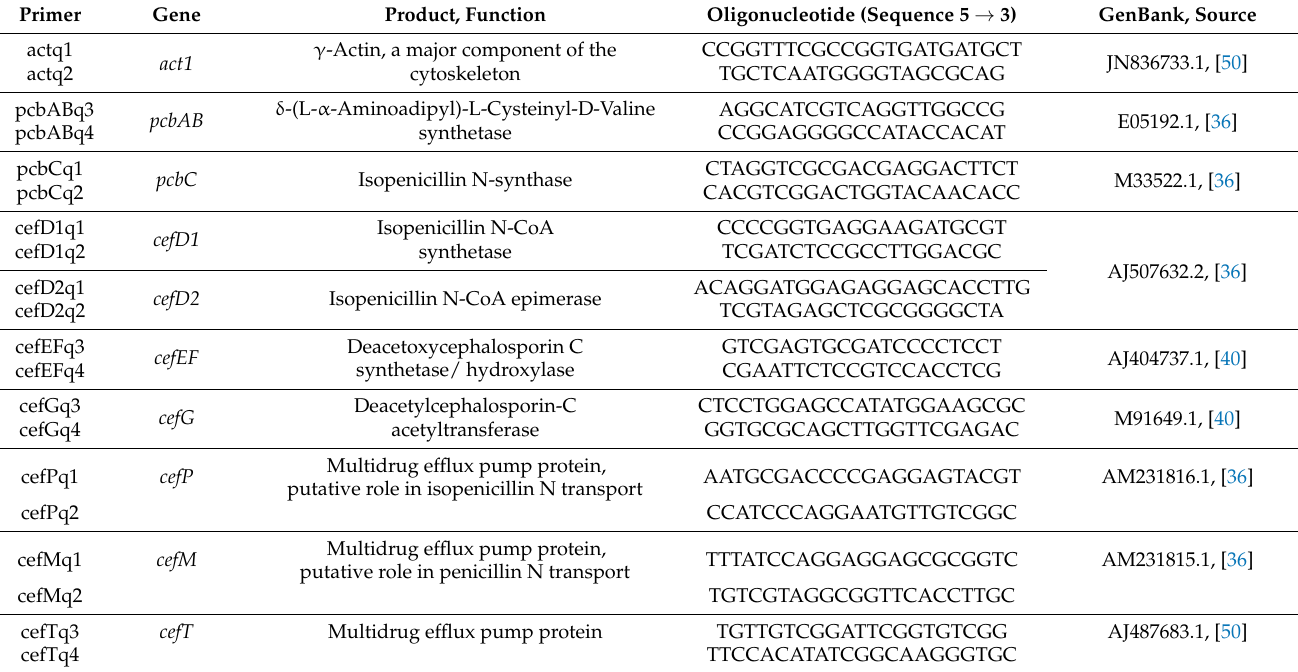
Table 1. Primers used for RT-PCR